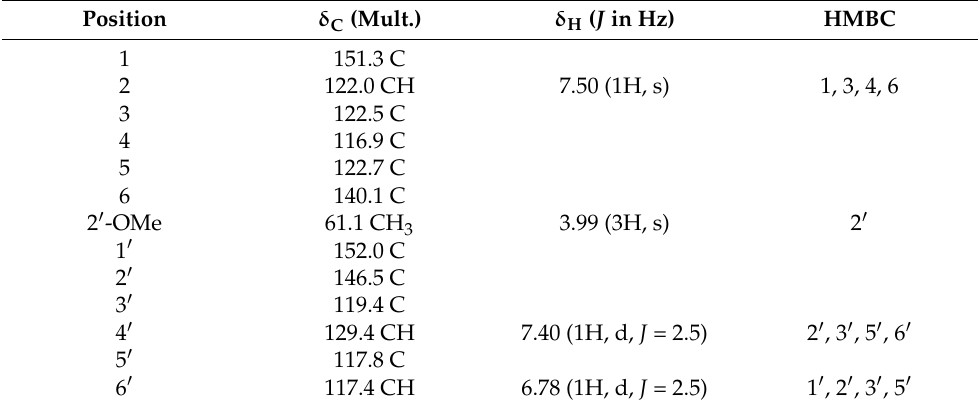
Table 1. 13 C (125 MHz) and 1 H NMR (500 MHz) data of 6 in Me 2 CO- d 6 . Position δ C